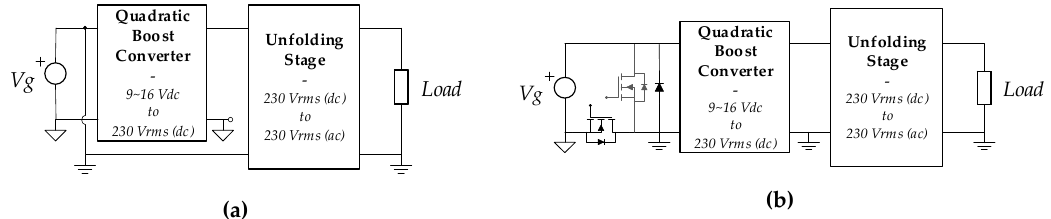
Figure 16. Solutions for the output voltage distortion in the “fast-slow” approach: ( a ) Unfolding stage differential connection, and ( b ) introducing a Buck-switch cell.